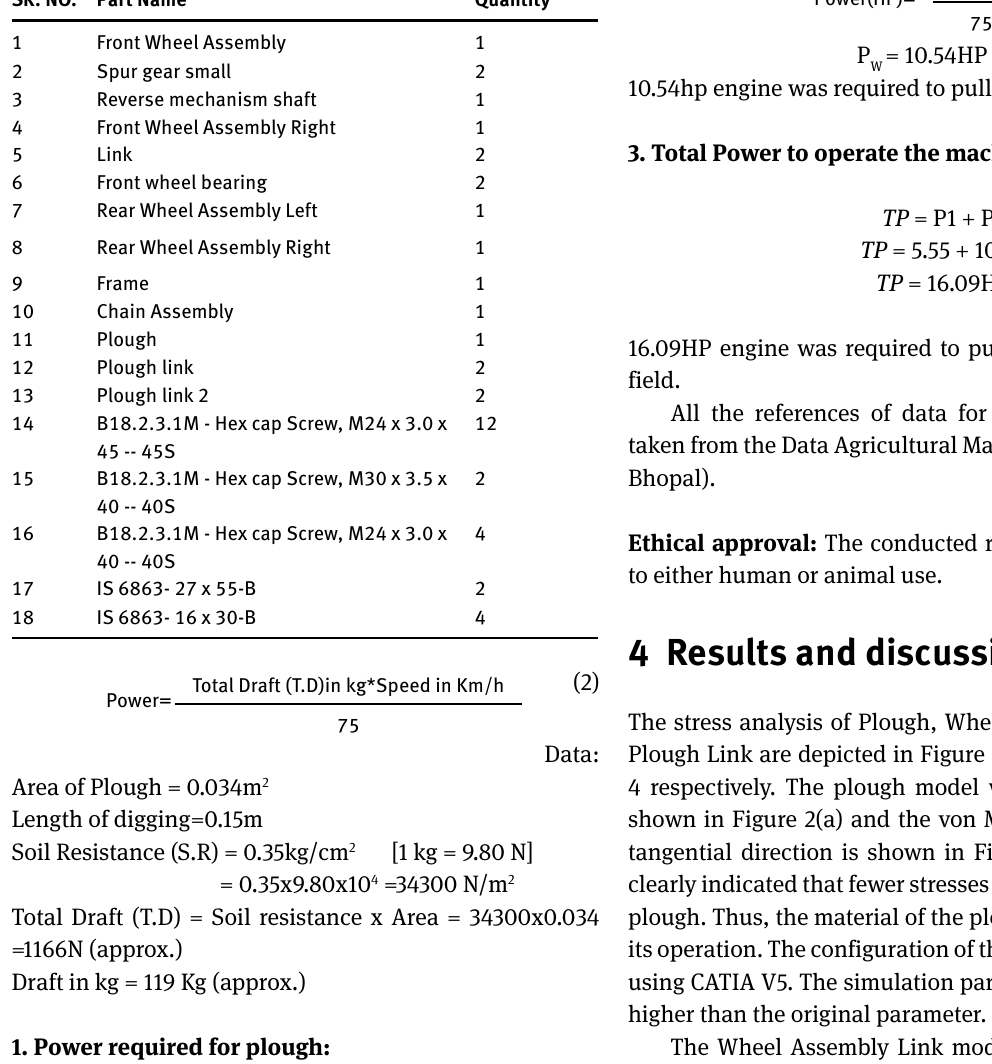
Table 1: List of Materials SR. NO. Part